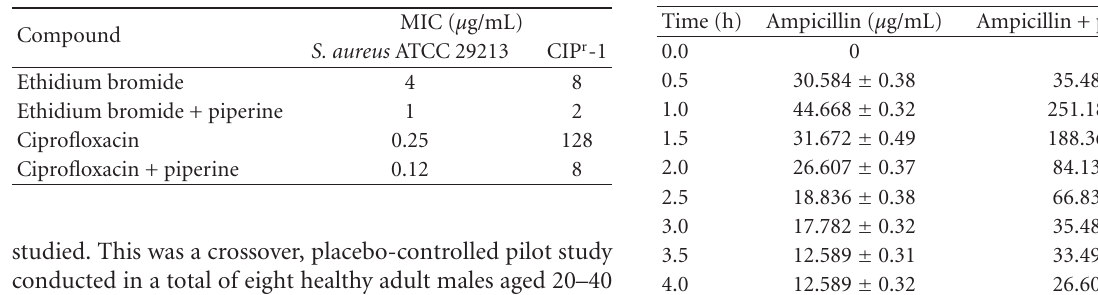
Table 11: Drug susceptibilities of S. aureus ATCC 29213 and the ciprofloxacin selected mutant (CIP r -1) [8].